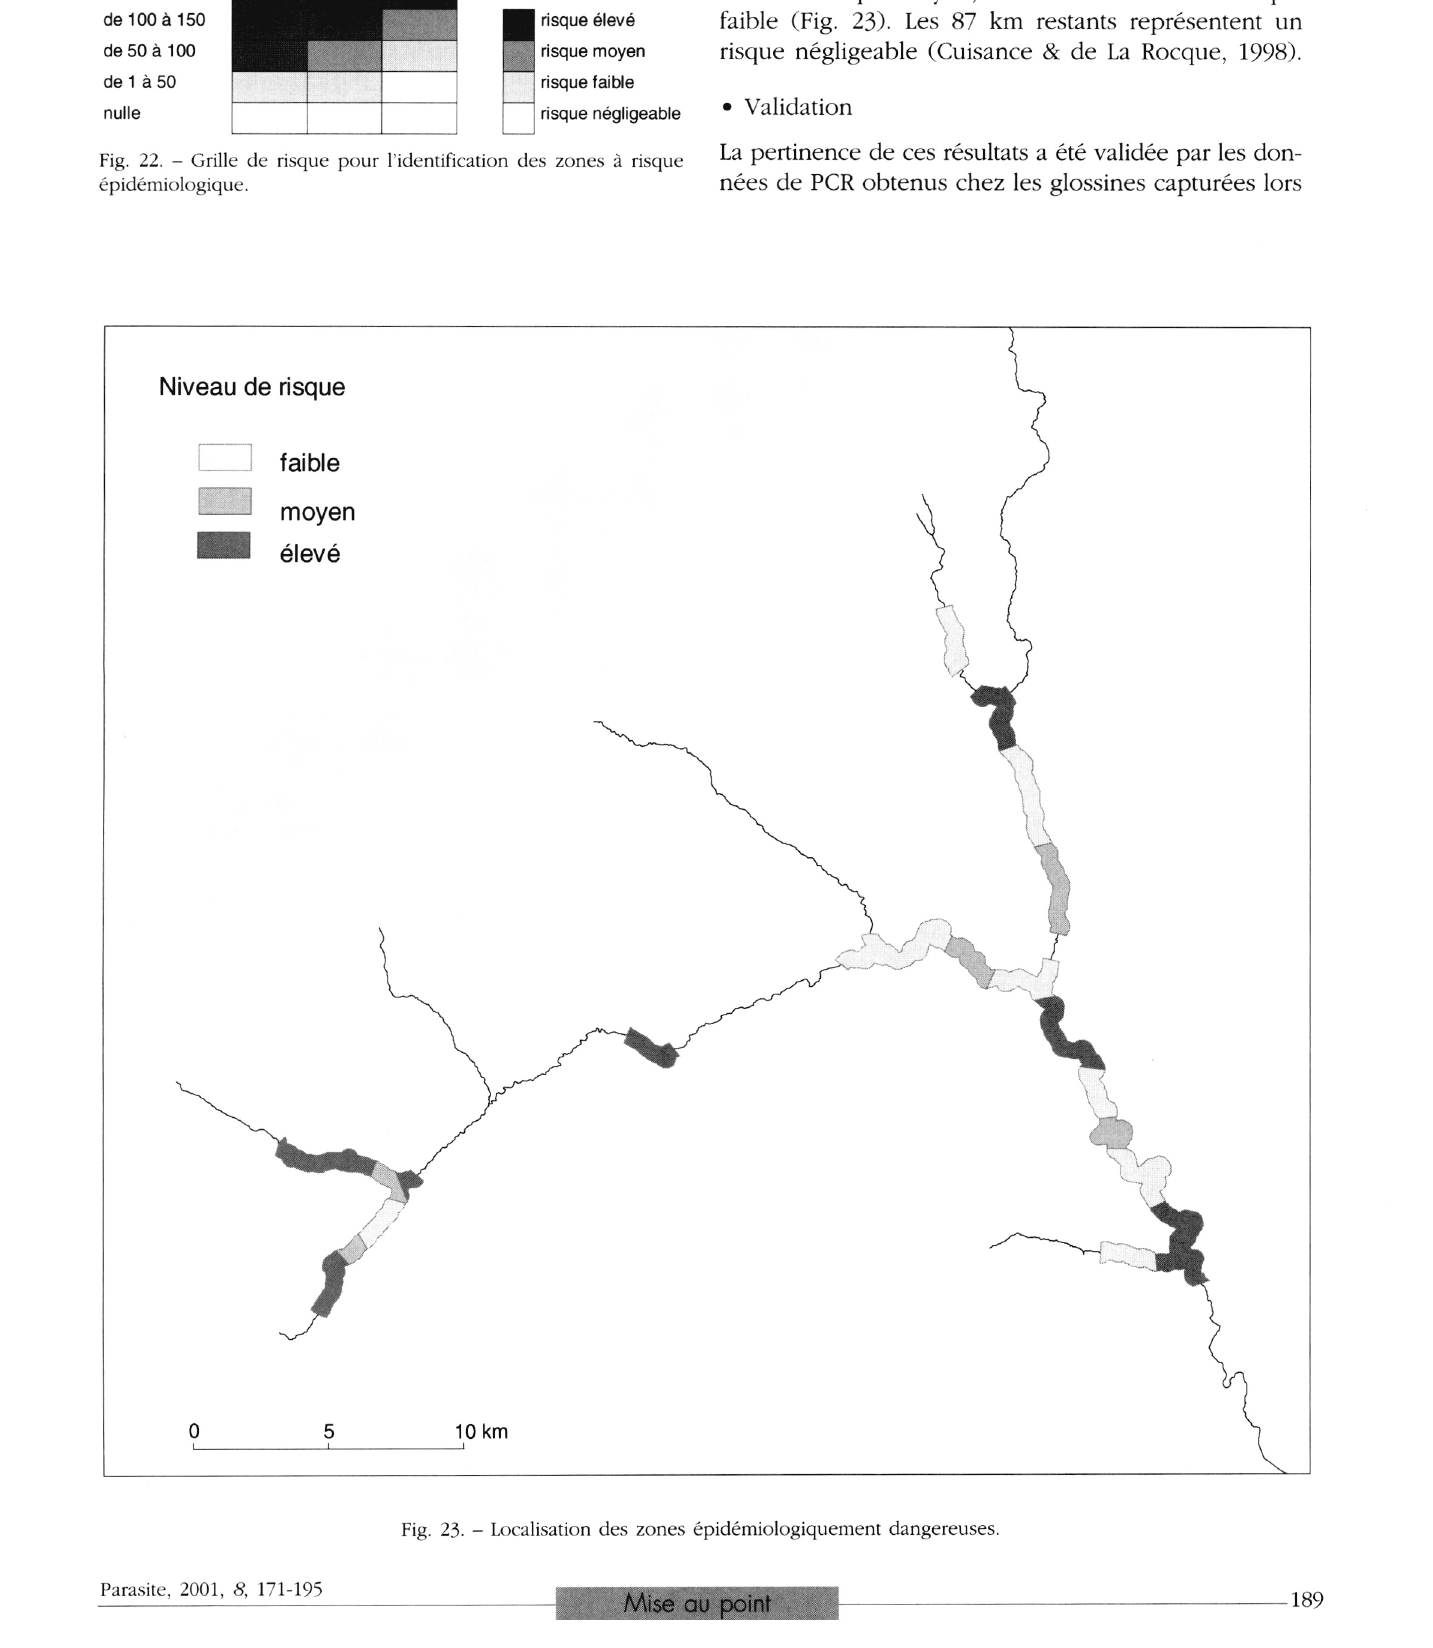
Fig. 23. - Localisation des zones épidémiologiquement